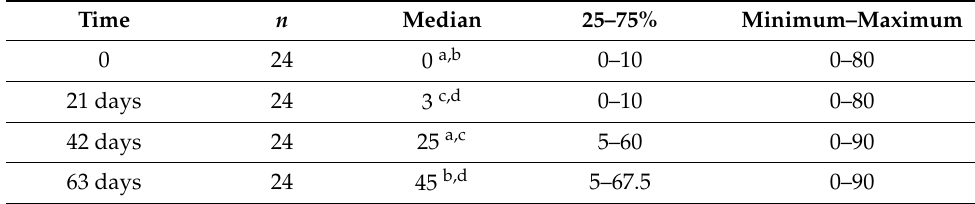
Table 4. Leopard gecko spermatozoa motility (%) over time.